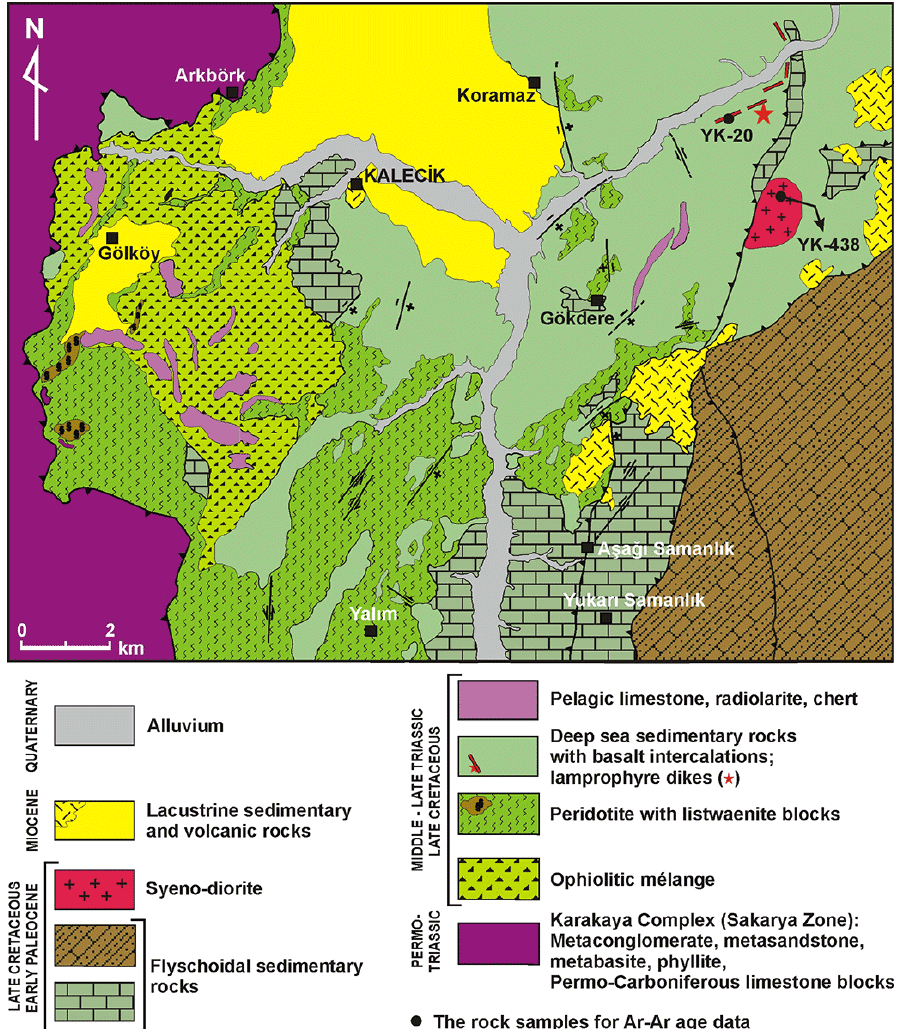
Fig. 3a. Geological map of the Kalecik area, east of Ankara, showing the distribution of the ophiolitic, turbiditic and island arc rock units in the Ankara Mélange in north-central